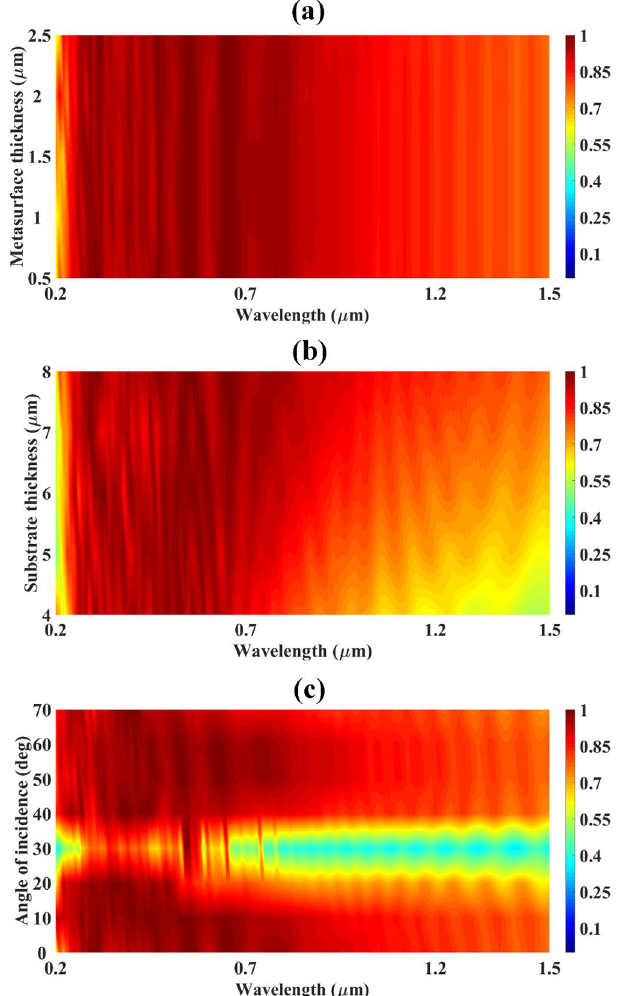
Figure 2. Absorption response of plus-shape slotted metamaterial solar absorber design while varying several physical parameters ( a ) Variation in absorption response while varying metasurface thickness. ( b ) Variation in absorption response while varying substrate thickness, ( c ) Absorption response while varying the angle of